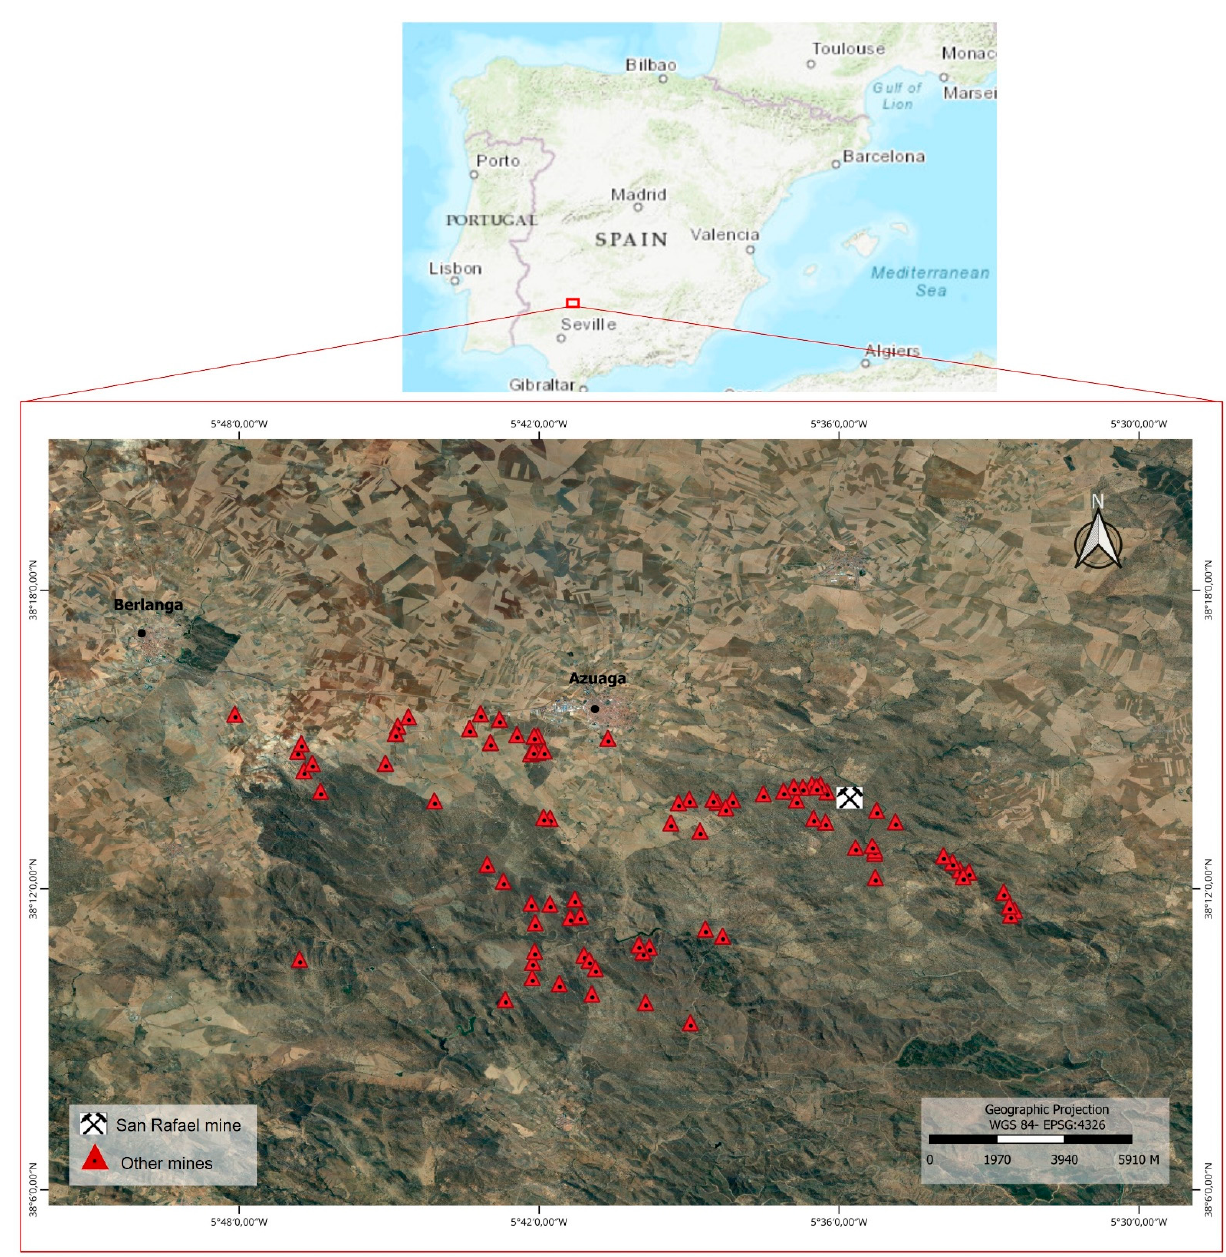
Figure 1. Location of the San Rafael mine (Azuaga, Spain).